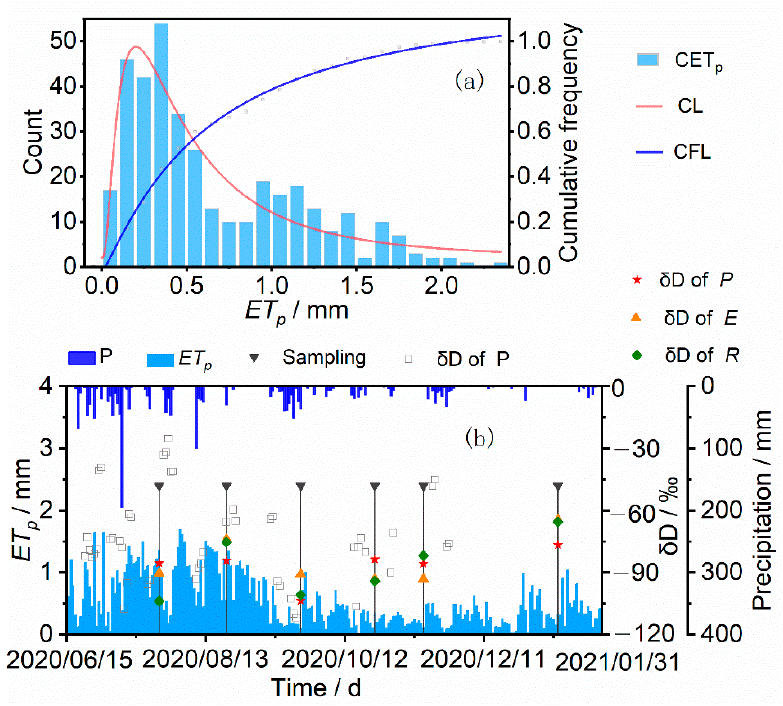
Figure 3. Frequency distribution of potential evapotranspiration ( ET p ) are shown in Figure ( a ). CET p represents the frequency of ET p in each group, and each group is a sequential accumulation of 0.1 mm; CL represents fitted curve of CET p ; CFL is frequency accumulation curve, respectively. In Figure ( b ), P is the daily precipitation; ET p is the potential evapotranspiration, and Sampling is the date of sampling. Isotopic values of precipitation ( δ D of P), P. taiwanensis ( δ D of P ), E. muricata ( δ D of E ) and R. dilatatum ( δ D of R ) are also shown in Figure ( b ), respectively.